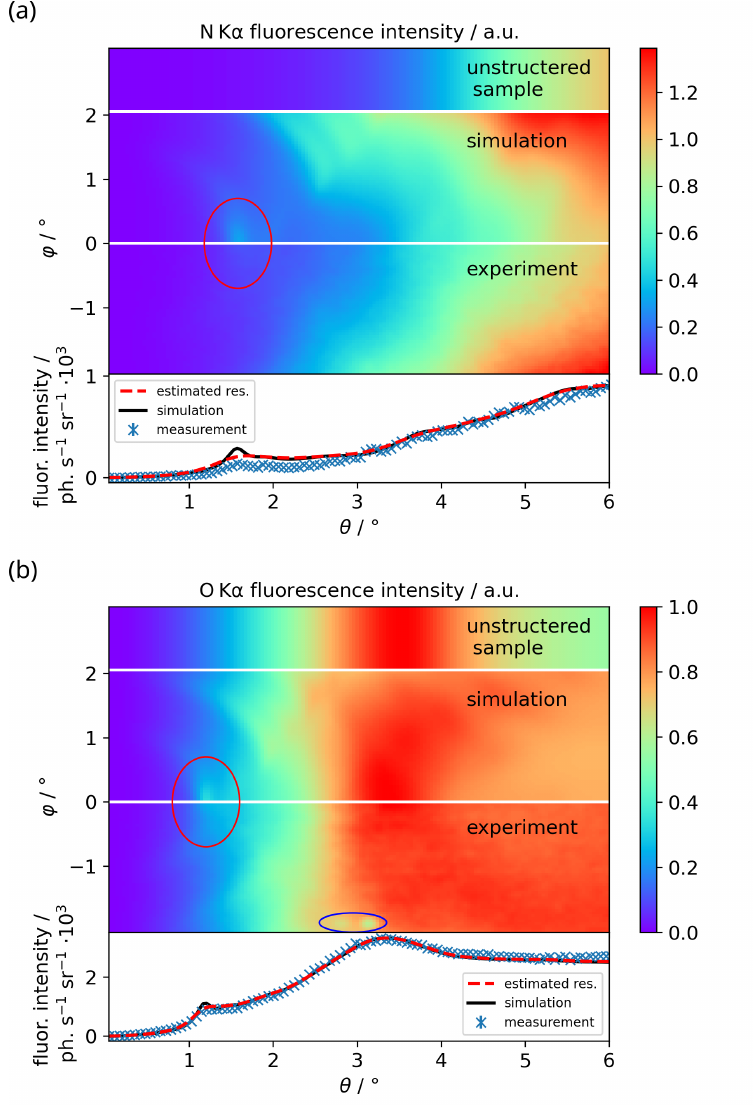
Figure 3. Measured and simulated θ - ϕ -maps and θ -profiles at ϕ = − 0.02° for ( a ) N K α on top and ( b ) O K α below from the Si 3 N 4 lamellar grating sample from the SF-GEXRF BESSY II measurement. The top parts of the maps show the θ - ϕ -maps for an unstructured sample with 90nm Si 3 N 4 on top of a silicon substrate and 3.5nm of SiO 2 as the top layer. Below are shown the simulated θ - ϕ -maps and the bottom θ - ϕ -maps depict the measured data. The experimental θ - ϕ -maps are smoothed with a Gaussian with an FWHM of 0.04° for presentation. The maps are normalized with the respective θ -profiles at ϕ = − 0.02°. The red ellipse highlights the interference feature between θ = 1° and θ = 2°. Some radiation damage artifacts of the CMOS chip from previous measurements are visible at the bottom of the O K α map, marked by a blue ellipse. The blue θ -profiles at the bottom depict the measurement data obtained from the Specfit evaluation. The error bars denote the statistical uncertainties. The black solid line denotes the simulation broadened by the calculated angular resolution due to the extended excitation footprint. The dashed red profile denotes the simulated profile convolved with a Gaussian with an FWHM of 0.1° in θ and ϕ direction for O K α and 0.2° for N K α to provide an estimation for the angular resolution achieved in the